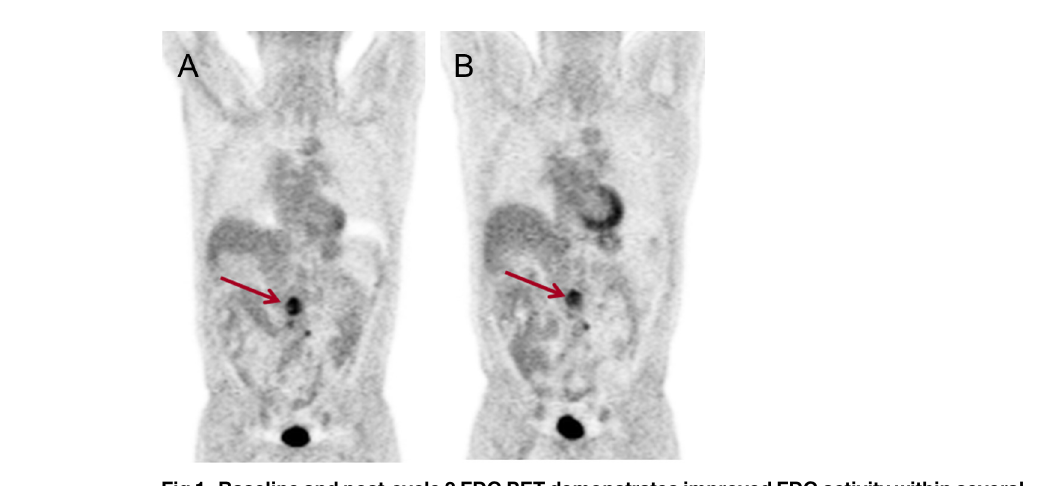
Fig 1. Baseline and post-cycle 2 FDG PET demonstrates improved FDG activity within several abdominal foci at the interim therapy scan (red arrows). Patient experienced PFS at 12 months clinical evaluation. Size measurements on post-cycle 2 MRI (not shown) depicted lesion shrinkage.